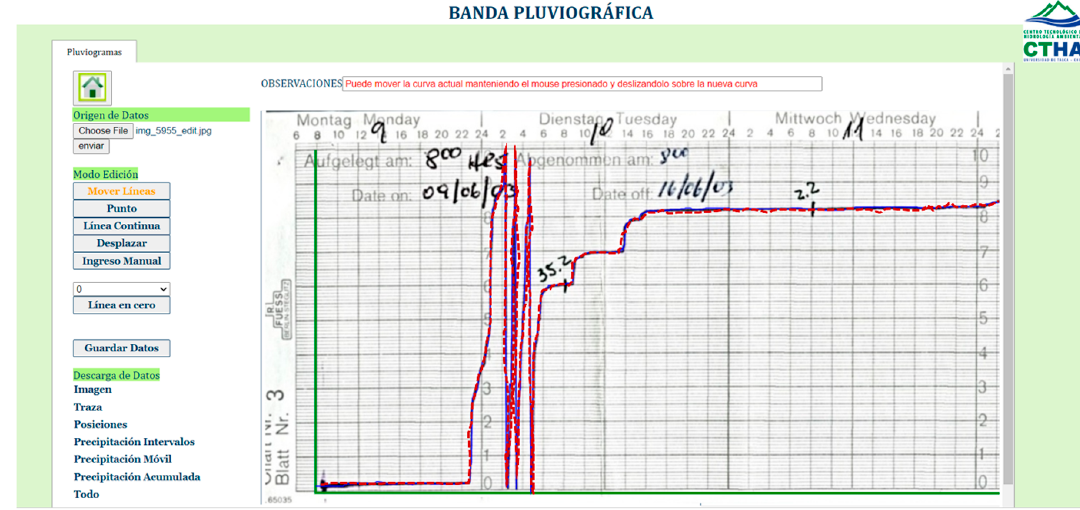
Figure 9. Report of digital image after trace detection, and post-editing the pluviograph band trace (red trace).